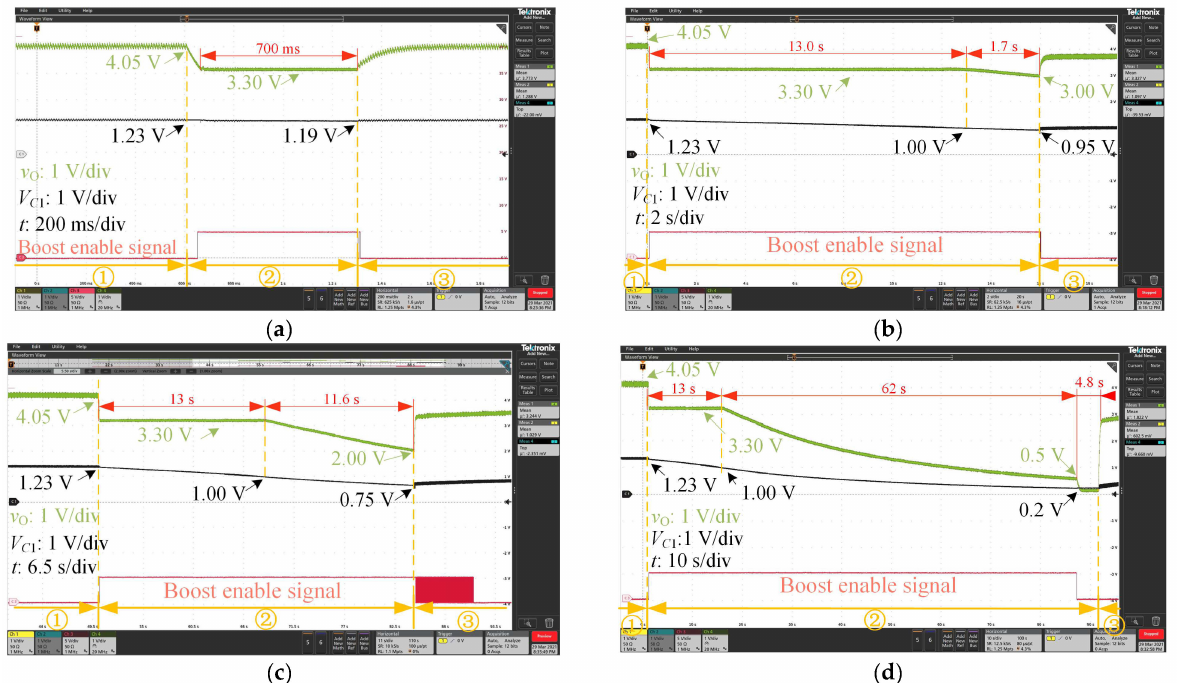
Figure 17. The mode transitions of the proposed dual-mode hybrid converter from the vibration’s existence ( 1 (cid:13) ) to the vibration’s disappearance ( 2 (cid:13) ), and to the resumption of the vibration ( 3 (cid:13) ). ( a ) the vibration is resumed after 700 ms of disappearance; ( b ) the vibration is resumed after 14.7 s of disappearance; ( c ) the vibration is resumed after 24.6 s of disappearance; ( d ) the vibration is resumed after 79.8 s of